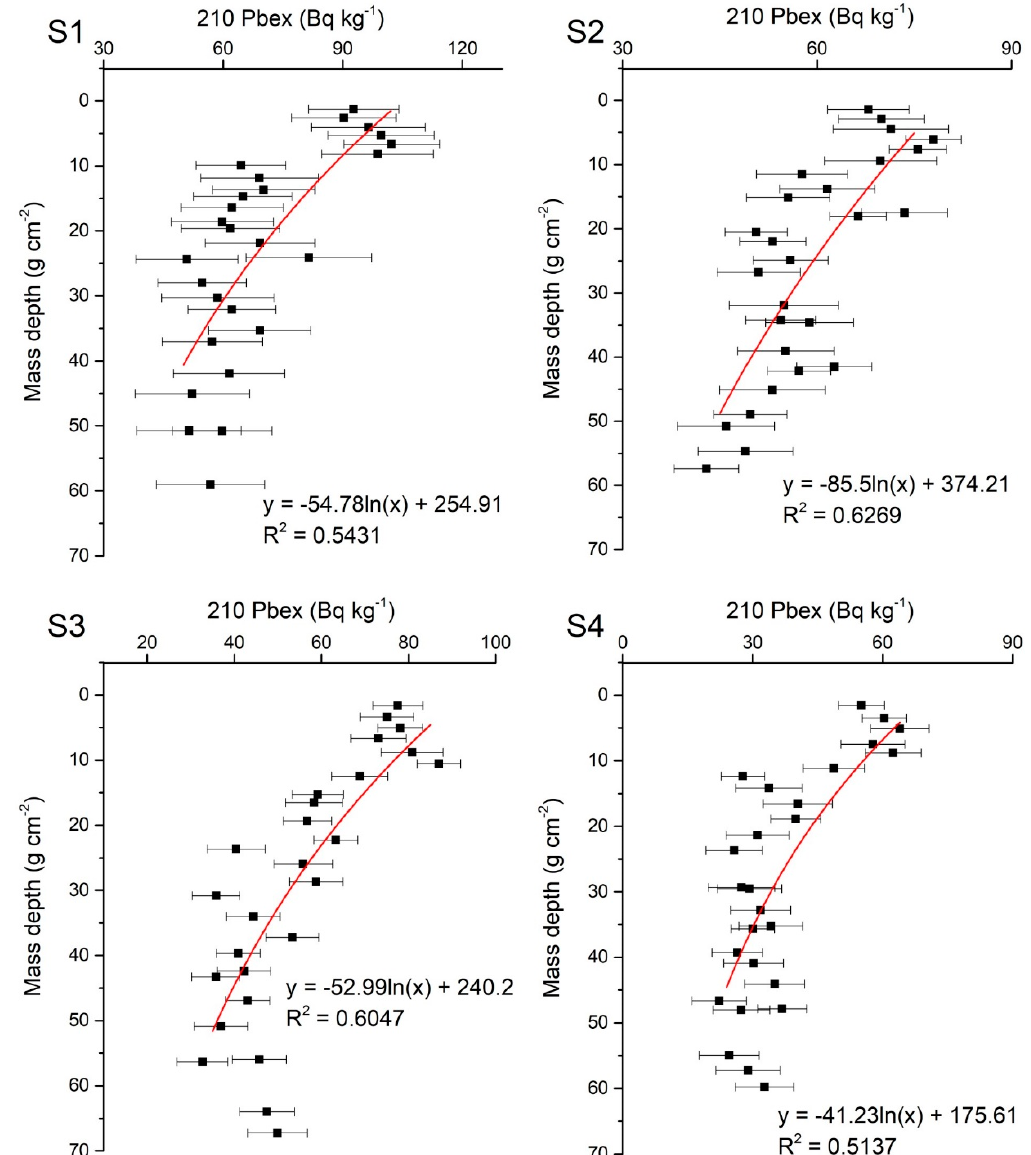
Figure 2. Radioactivity of excess 210 Pb ( 210 Pb ex ) in sampling sites. S1-4 present the sampling sites in Figure 1.